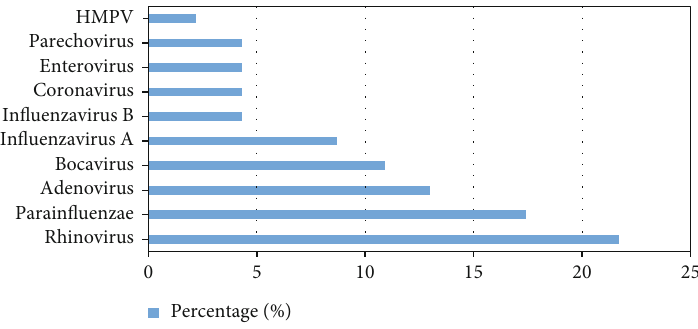
Figure 1: Distribution of other viral pathogens in NPS of children with RSV (+)